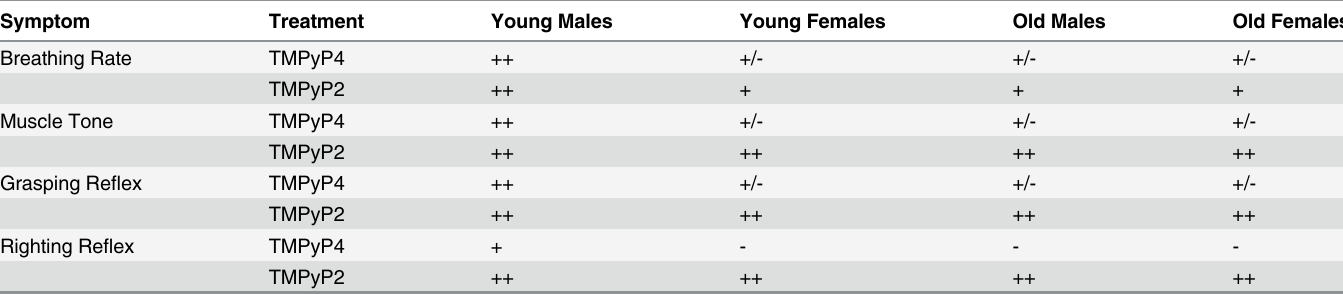
Table 1. Physiological symptoms observed following a single injection with a high dose (40mg/kg) of either TMPyP2 or TMPyP4. Symptom Treatment Young Males Young Females